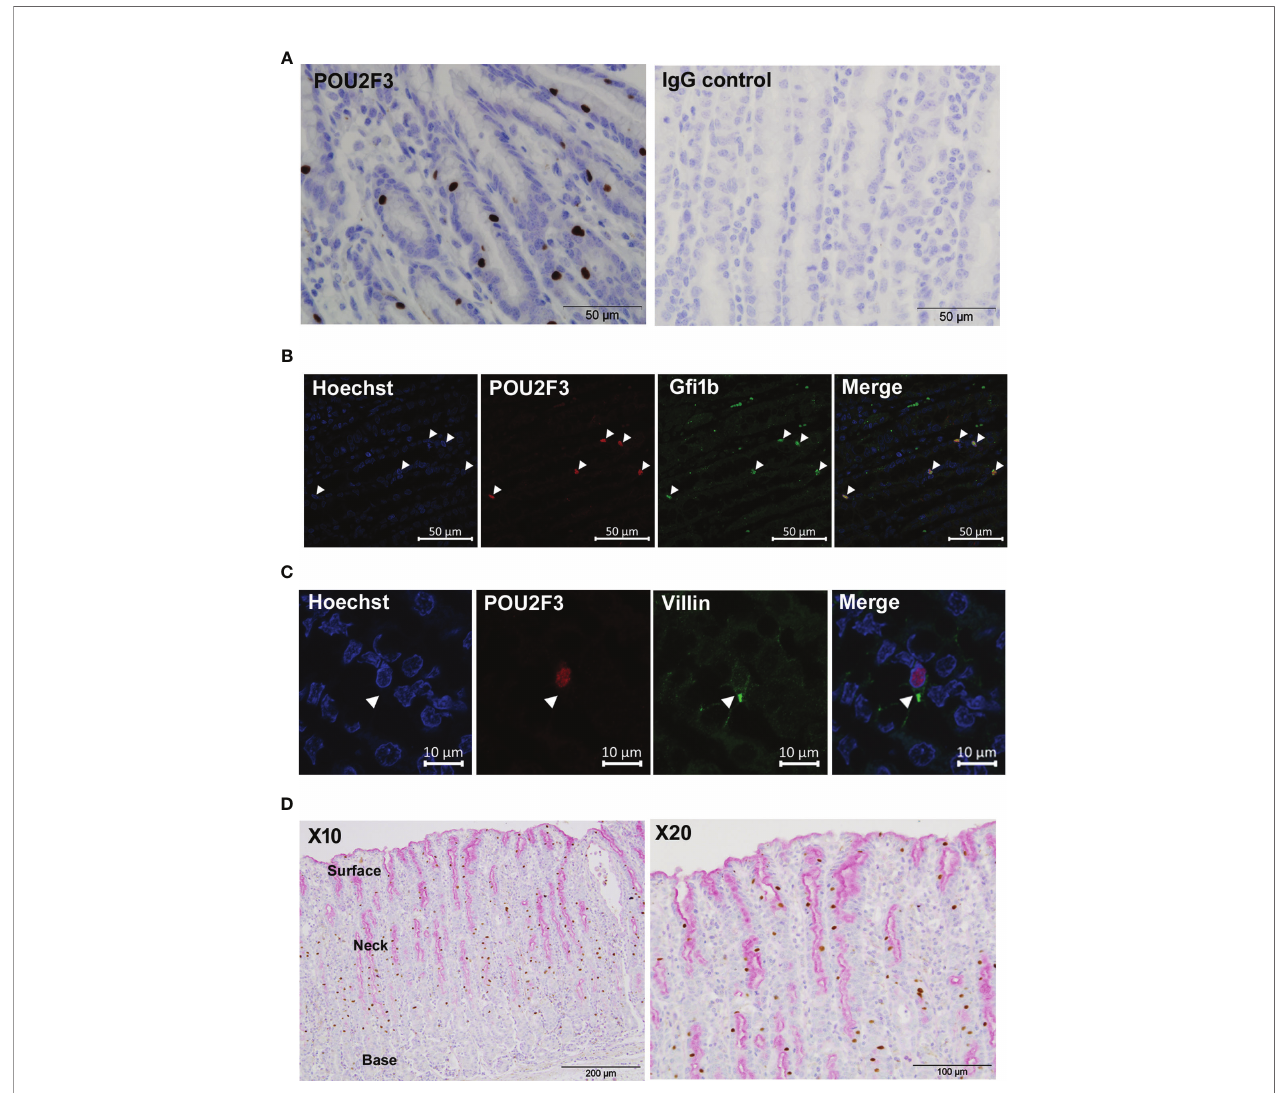
FIGURE 1 | Identi fi cation of tuft cells in ovine abomasal epithelium by immunohistochemistry. (A) Detection of tuft cells using antibody to human POU2F3 (brown) in ovine abomasal epithelium sections at day 21 post-infection with Teladorsagia circumcinta (left hand panel). Surrounding epithelial cells are counterstained with hematoxylin blue. IgG isotype control antibody showed no labelling (right hand panel). (B) Co-localization of antibodies to POU2F3 and GFI1b in ovine tuft cell nucleus. Arrowheads indicate nuclear localization of each antibody individually and in the merged image. Nuclei were stained with Hoechst. (C) Detection of apical tuft on POU2F3 + cells (red) with antibody to villin (green). Arrowhead indicates tuft-like structure on double-labelled cell. Nuclei were stained with Hoechst. (D) POU2F3 + cells are distinct from mucin-secreting cells. Co-labelling with POU2F3 antibody (brown) and mucin stain Periodic Acid-Schiff (pink), which localizes to the surface mucus layer and to surface and neck mucous cells, predominantly at the apical (upper) edge of the abomasal epithelium. Areas of surface and neck mucous cells and the base of the gastric glands are